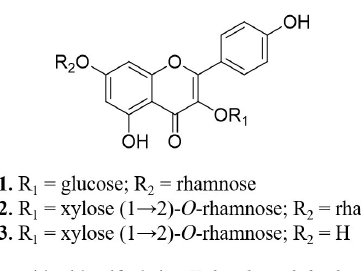
Fig. 9: Flavonoids identified in Kalanchoe fedtschenkoi aqueous leaf- extracts based on comparison with pure compounds: kaempferol 3- O -glucopyranoside 7- O -rhamnopyranoside ( 1 ), kaempferol 3- O -β- D-xylopyranosyl (1 → 2)- O -α-L-rhamnopyranoside 7- O -α-L-rham- nopyranoside ( 2 ; sagittatin A), and kaempferol 3- O -β-D-xylopy- ranosyl (1 → 2)- O -α-L-rhamnopyranoside ( 3 ). 8.32 ± 1.43 μg/mL, which was very similar to that of the positive control (8.94 ± 0.9 μg/mL), a standardized Ginkgo biloba extract (Te- bonin ® ), well known for its high antioxidant activity. Our findings indicate that K. fedtschenkoi has great antioxidant potential,